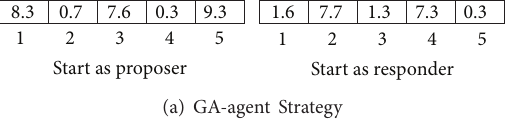
Figure 11: PSO-agent versus DE-agent.